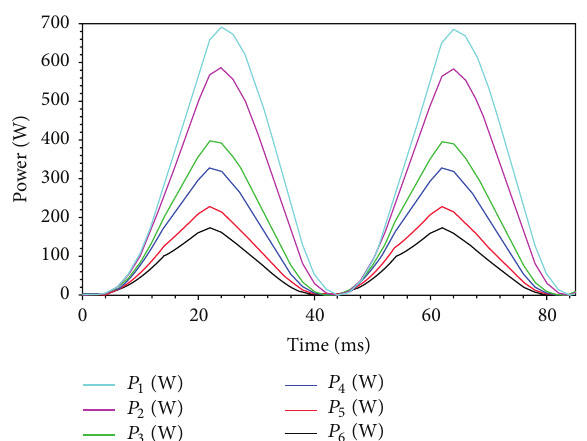
vertical velocity of the wave elevation is a cosine function. The vertical position and velocity of the translator are shown in Figure 18. The time period 𝑇 = 4 s and 𝐿 𝑆 = 1.6 m which Figure 17: Generated power for different loads. means 𝐴 𝑤 = 0.8 m. The magnitude of the generated voltage